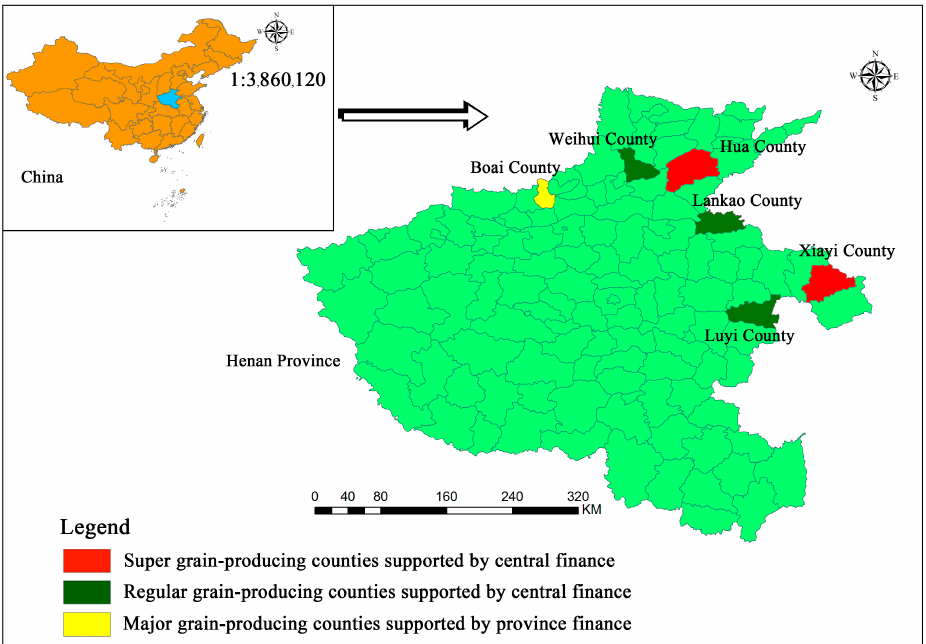
Figure 2. Map of six major grain-producing counties selected in this study.